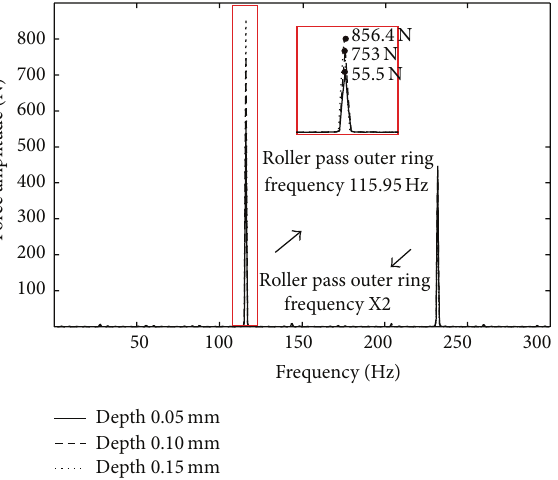
Figure 9: Defect depth: force spectrum for defect outer raceway in vertical direction.